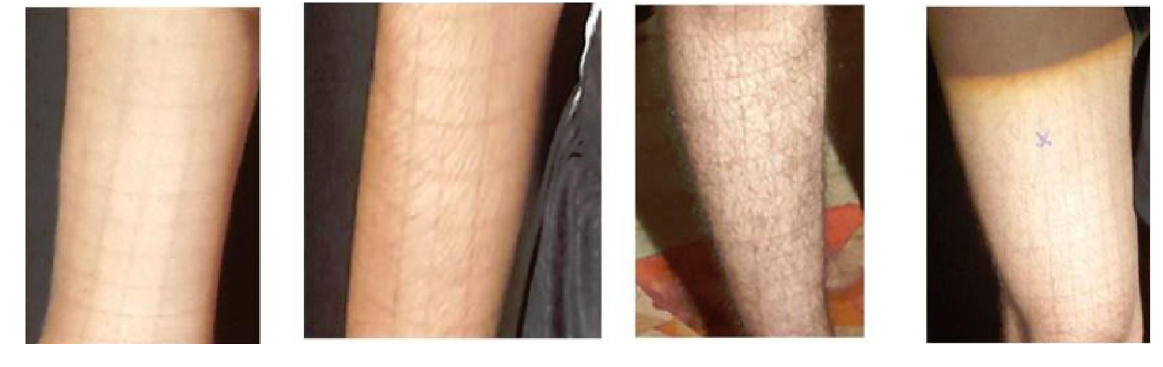
FIG. 5. CYLINDRICAL BODY PARTS OF THE